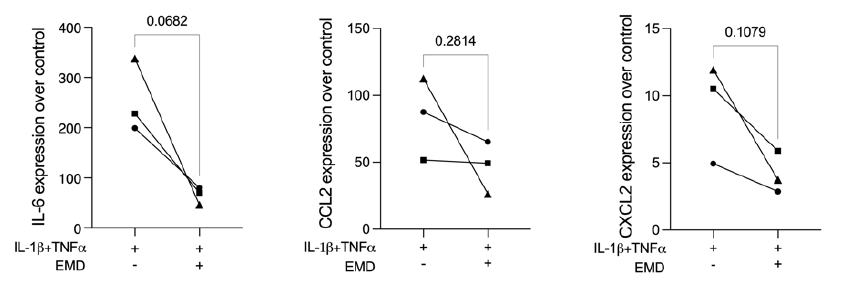
Figure 6. IL-1 β and TNF- α stimulation caused a strong expression of IL-6, CCL2, and CXCL2 in ST2 cells. The application of EMD prior to IL-1 β + TNF- α stimulation in ST2 cells led to a trend in the reduction of the forced expression of inflammatory markers. Different symbol shapes mean independent experiments. Paired t -test statistical analysis was applied to compare the groups.